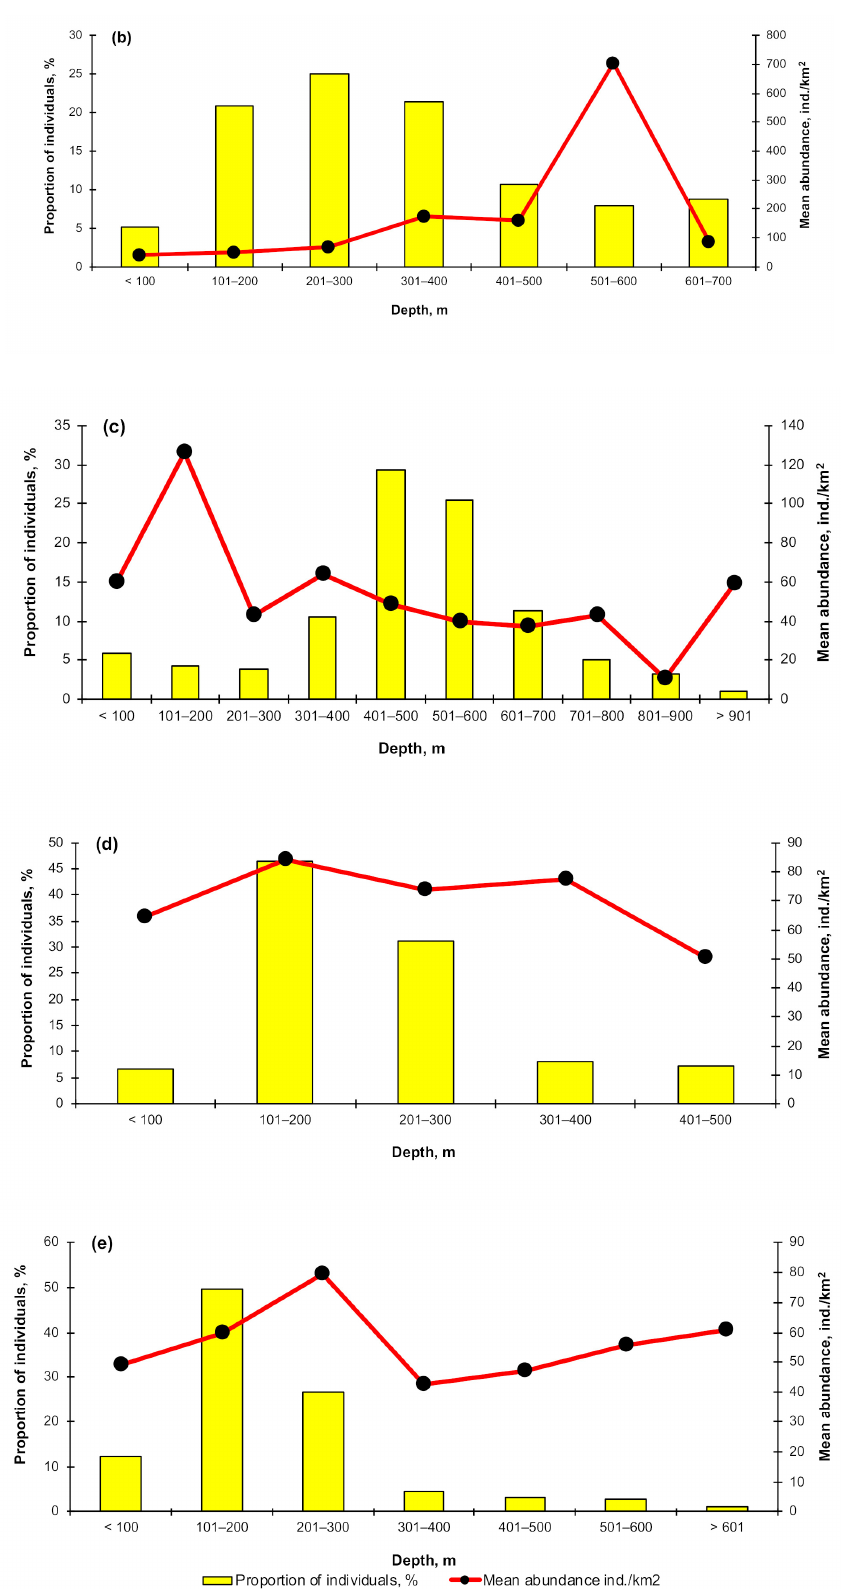
Figure 7. Depth distribution of the Aleutian skate Bathyraja aleutica from different regions of its range: ( a ) Bering Sea, ( b ) NWPO, ( c ) Sea of Okhotsk; ( d ) Aleutian islands, ( e ) Gulf of Alaska.